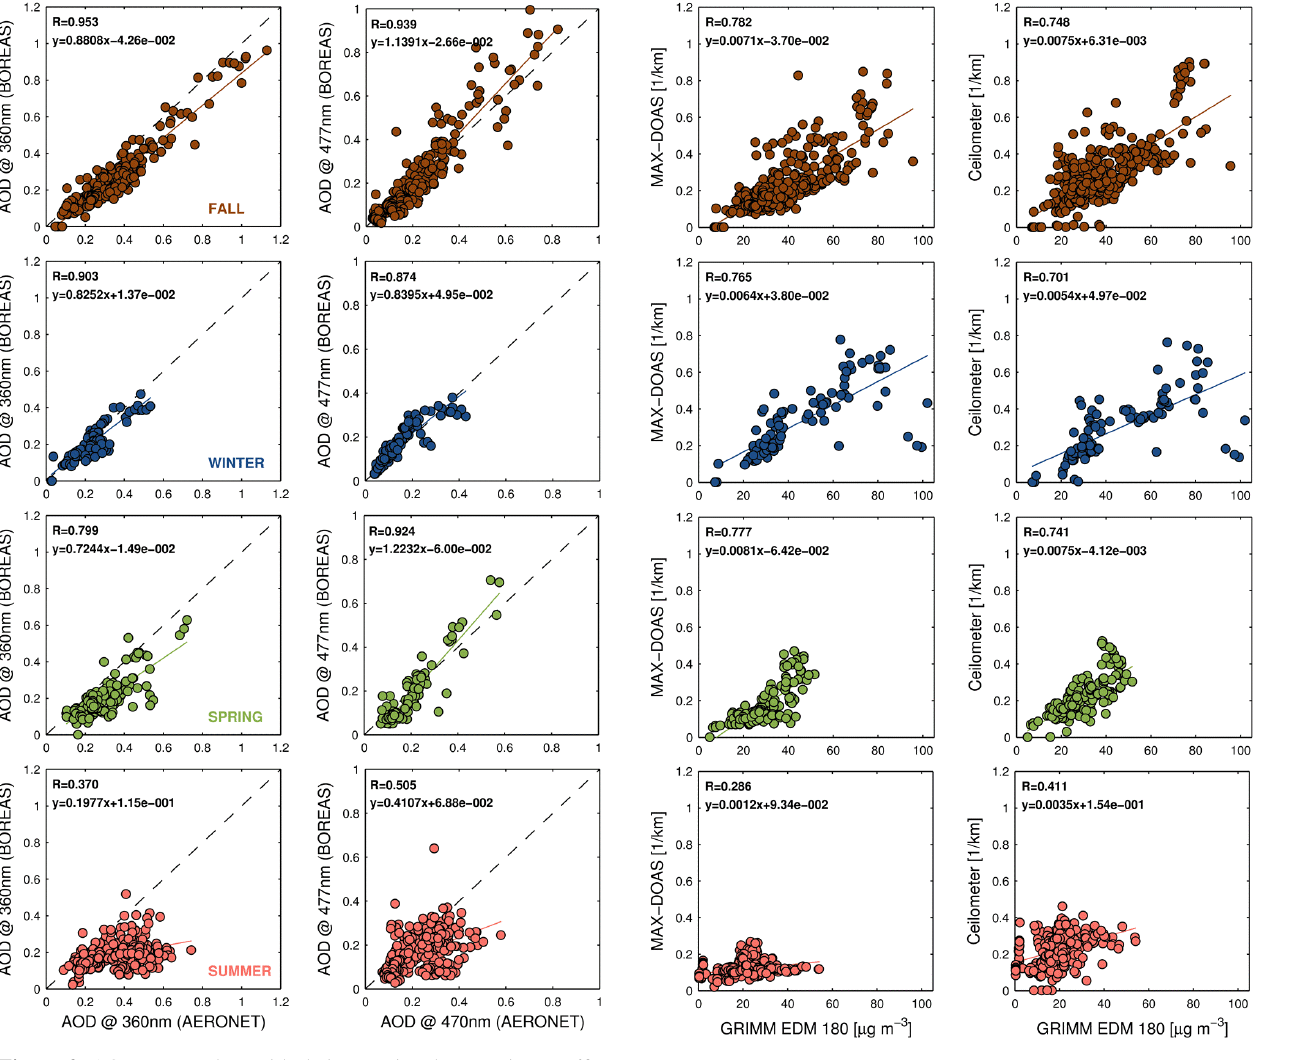
Figure 10. AE scatterplots with their associated regression coeffi- cients for the fall (brown), winter (blue), spring (green), and sum- mer (red) seasons, illustrating the linear relationship of BOREAS (B; see Fig. 1) (left panels) and ceilometer (Z; see Fig. 1) (right panels) near-surface AE (1km − 1 ) retrieved in the UV channel vs. surface PM 10 concentrations (µgm − 3 ) from the in situ monitoring station. Data of cloud-free days as defined in Sect. 2.2.4 between 1 September 2017 and 31 August 2019 are included in the